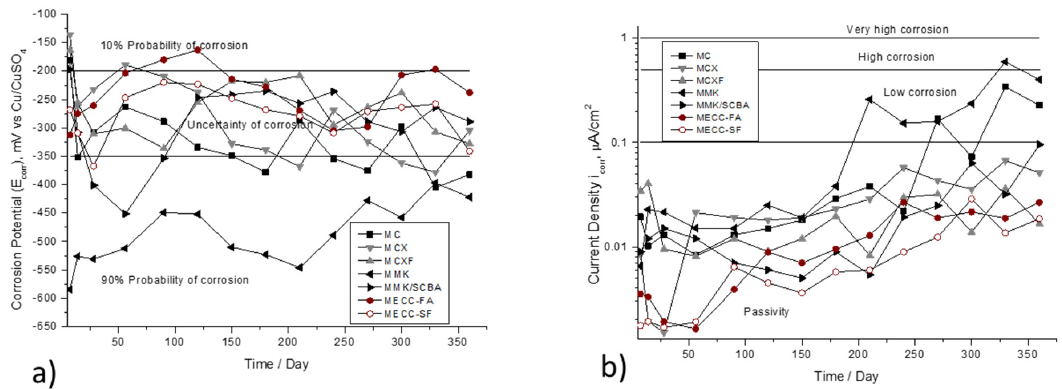
Figure 3. Corrosion behavior of AISI 1018 CS in mortars exposed in 3.5 wt % NaCl solution. ( a ) Half-cell potential (E corr ). ( b ) Current density (i corr ).